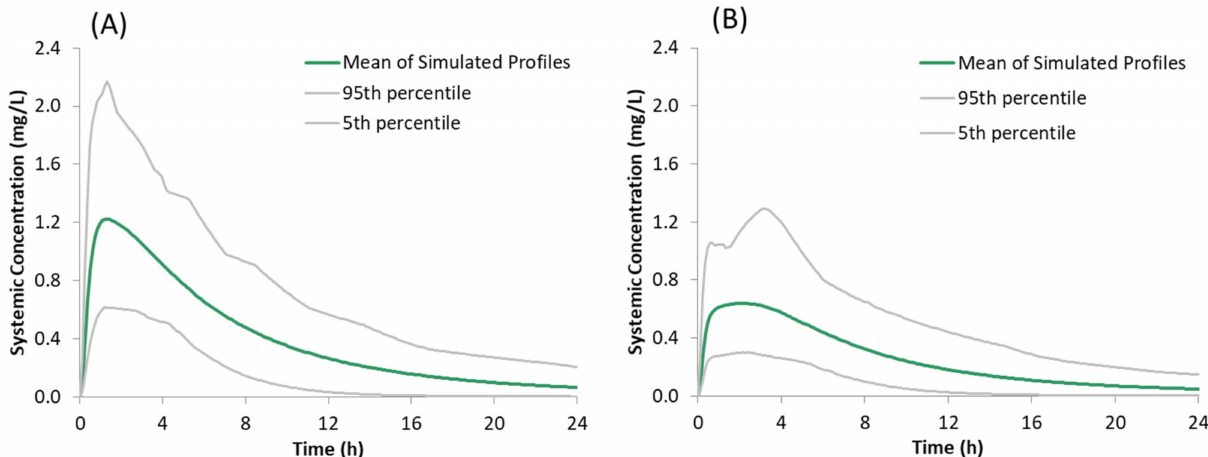
Figure 6. Simulated plasma concentration time profiles of the model compound following oral administration of 150 mg of the salt form under fasted conditions: ( A ) without famotidine and ( B ) with famotidine co-dosing.